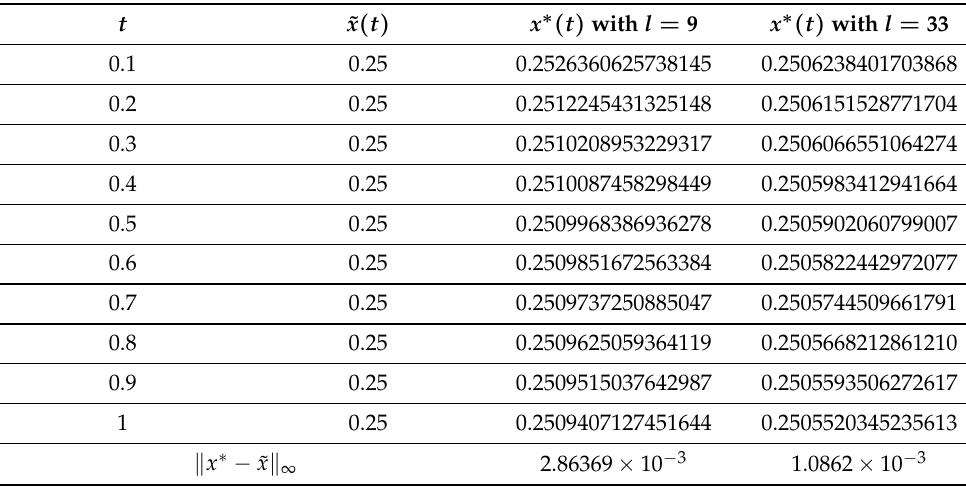
t ˜ x ( t ) x ∗ ( t ) with l = 9 x ∗ ( t ) with l = 33